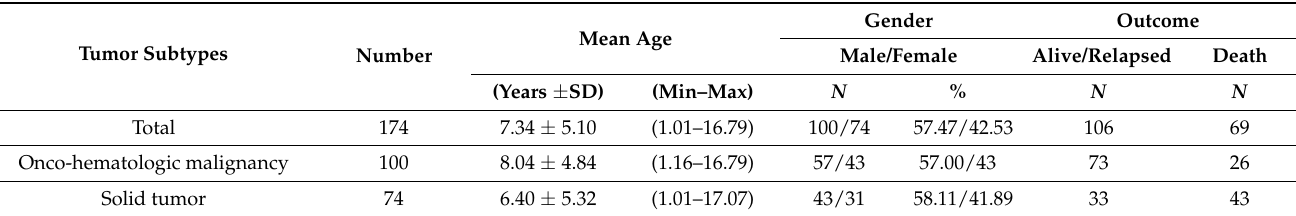
Table 1. Patients demographic